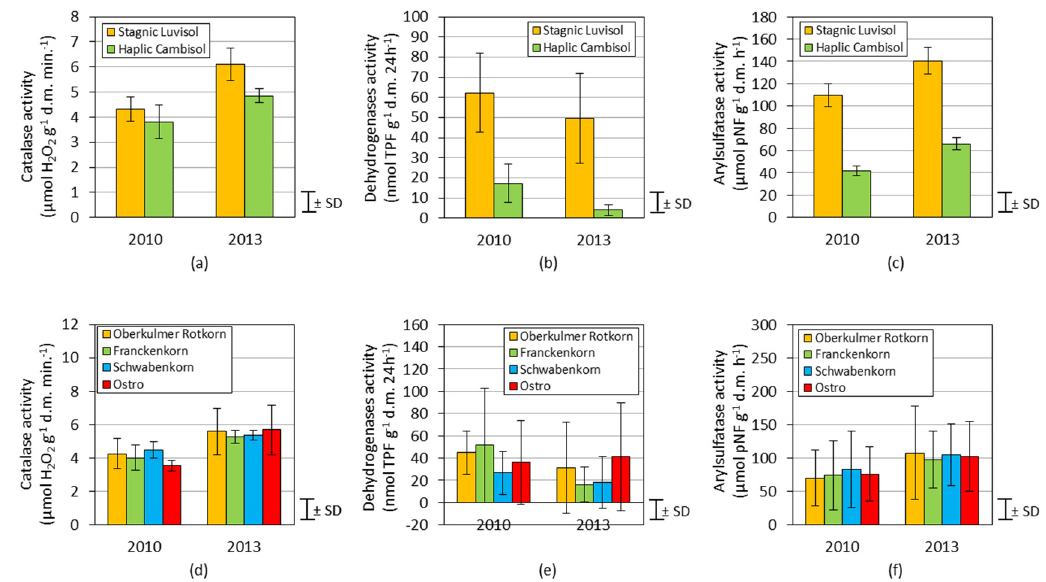
Figure 1. Activities of catalase, dehydrogenases and arylsulfatase in soil:.(a, b, c) Means for soil types; (d, e, f) means for spelt variety; SD—standard deviation.